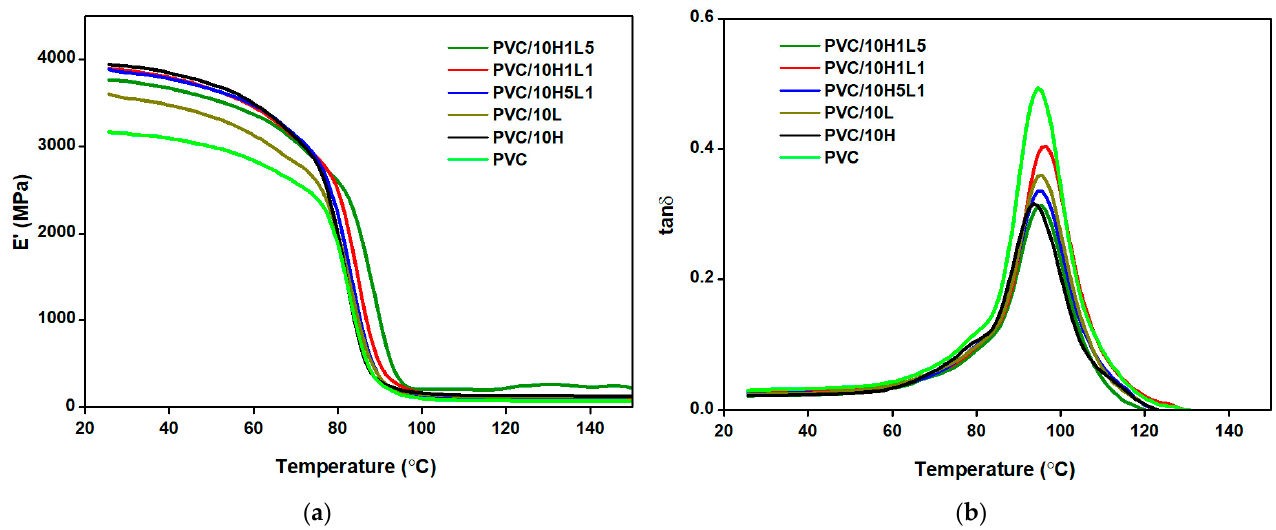
Figure 8. DMA thermograms of PVC and PVC composites with 10 wt% of fillers: storage modulus ( a ) and loss factor ( b